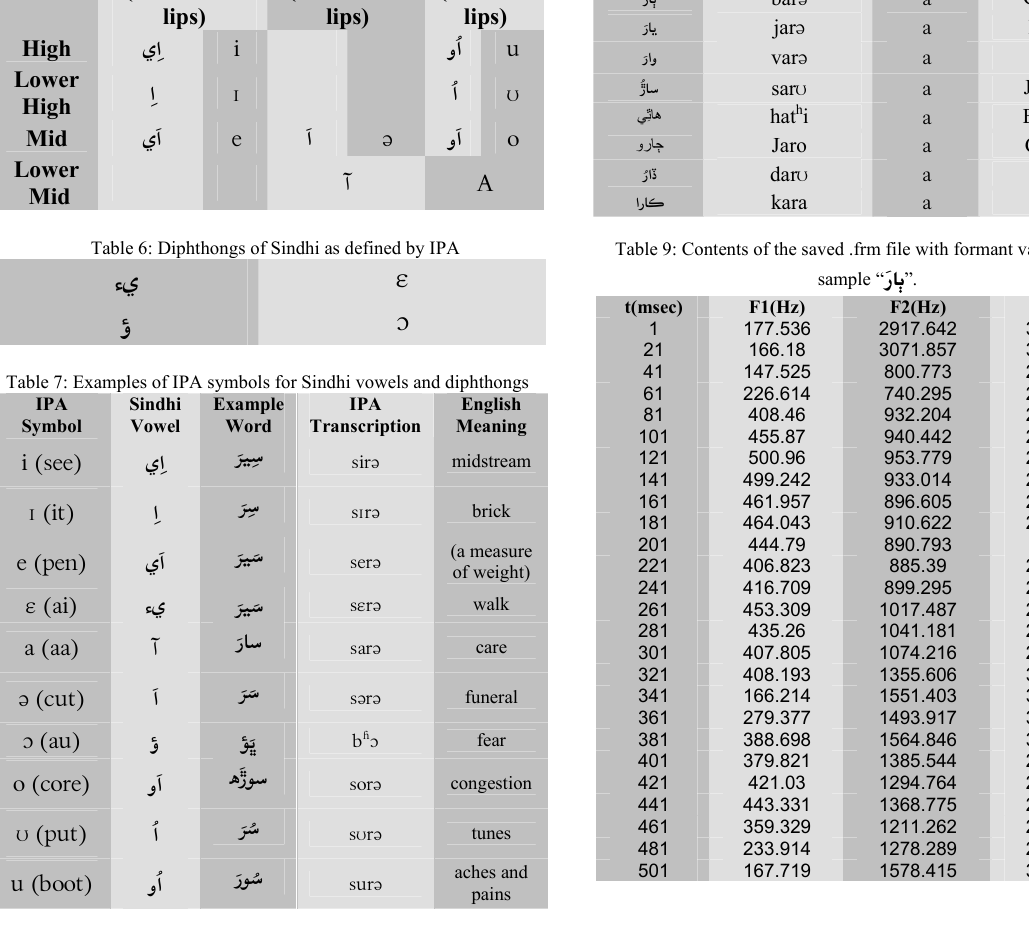
Table 5: Classification of Vowels by IPA Table 8: List of selected Sindhi words Tongue